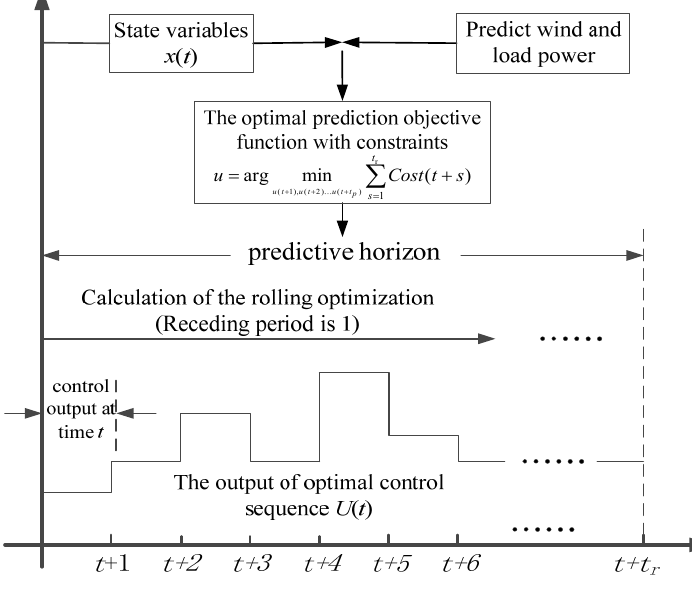
Figure 8. Flowchart of energy coordinative